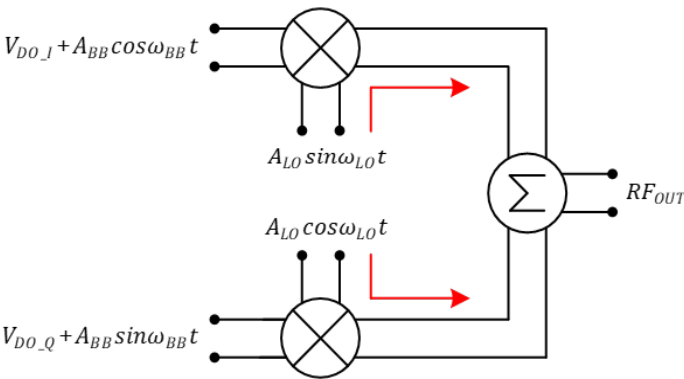
Figure 6. LO leakage generation in direct conversion transmitter.